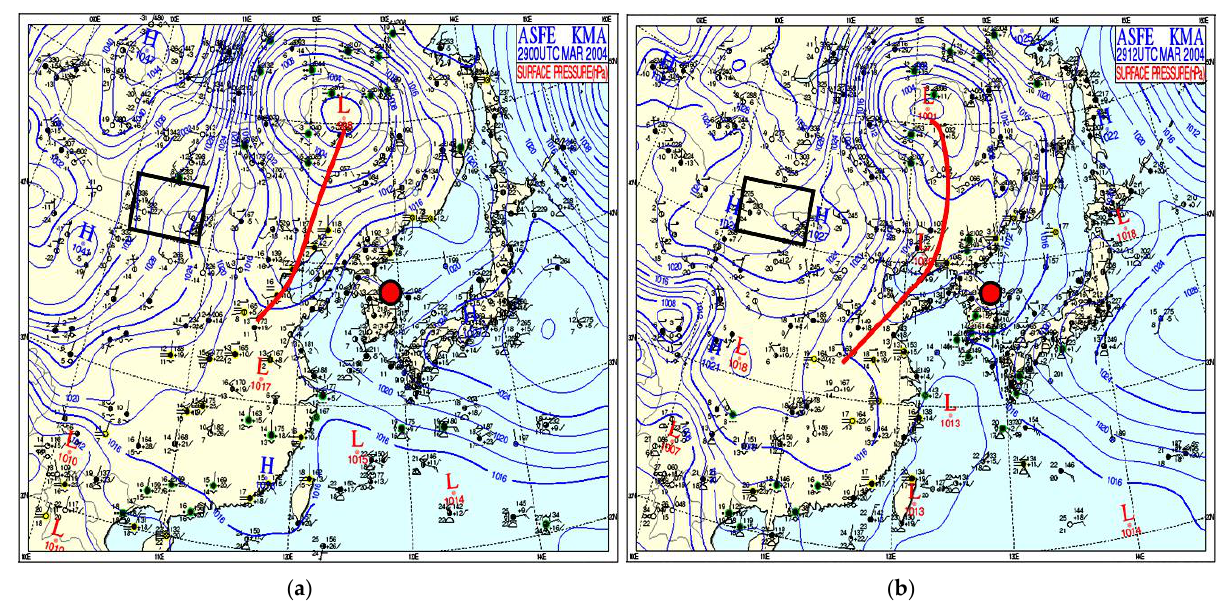
Figure 4 . Surface pressure and at ( a ) 09:00 UTC (00:00 LST), 29 March 2004, and ( b ) 12:00 UTC (21:00 LST). A small square, a thick red line, and a small circle denote the Gobi Desert, the cold front, and Gangneung city, respectively.